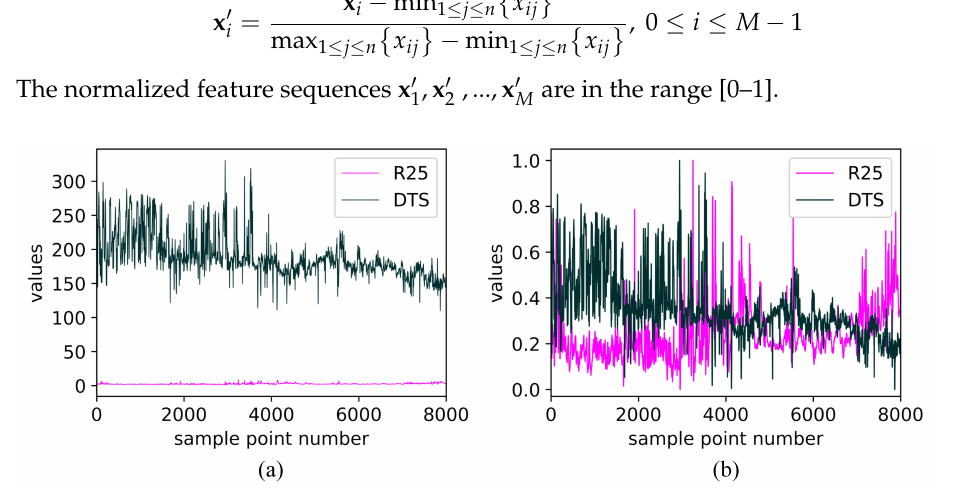
Figure 5. Distributions of R25 and DTS from the ( a ) original dataset and ( b ) standardization dataset.